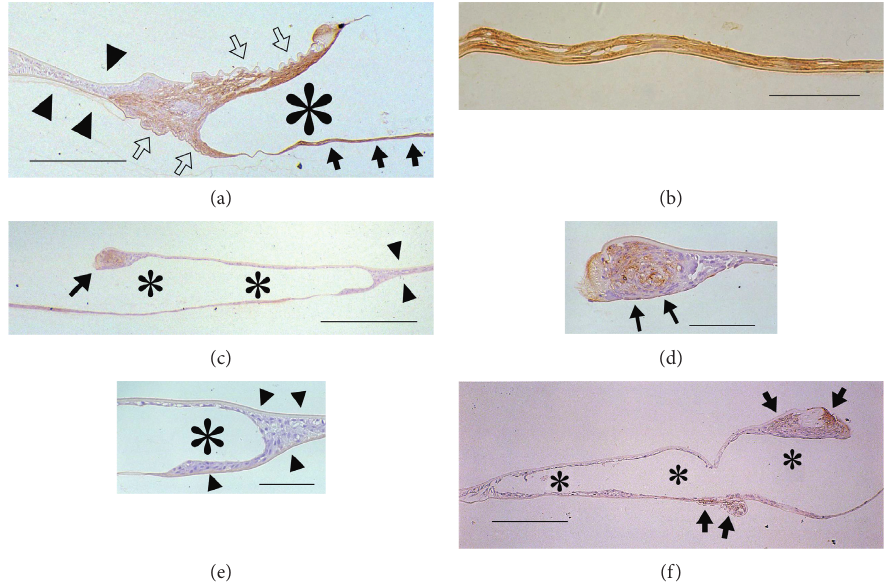
Figure 2: Immunolocalization of α -SMA in pseudophakic rabbit eyes 5 days after cataract surgery. The flattened and multilayered LECs are positive for α -SMA. The specimens could be divided into two groups according to the distribution of these α -SMA-positive LECs around the IOL optics. (a) Surrounding type: LECs positive for α -SMA surround the IOL optic. The anterior and posterior capsules around such LECs appear wrinkled (open arrows) except for the posterior capsule under the IOL optic (arrows). The inner surface of the peripheral anterior and posterior capsule is covered by a monolayer of LECs, with these two surfaces being attached to each other like a zipper (arrowheads), which are separated from the IOL optic by α -SMA-positive LECs around the IOL optic edge. These LECs are negative for α -SMA. Bar � 250 μ m. (b) Higher power view of (a): the central posterior capsule under the IOL optic is covered by α -SMA-positive LECs without wrinkling of the capsule. (c) Restricted type: LECs positive for α -SMA are present only around the margin of the anterior capsule (arrow). Other LECs around the IOL optics are negative for α -SMA, with most of them forming a monolayer. The inner surface of the peripheral anterior and posterior capsule is also covered by a monolayer of α -SMA-negative LECs (arrowheads). Bar � 400 μ m. (d) Higher power view of (c): the margin of the anterior capsule is covered with α -SMA-positive, flattened LECs (arrows). Bar � 75 μ m. (e); higher power view of (c): LECs around the edge of the IOL optic and on the inner surface of the peripheral anterior and posterior capsules are α -SMA-negative (arrowheads). Bar � 75 μ m. (f) Restricted type: LECs positive for α -SMA are present around the margin of the anterior capsule and on small areas of the posterior capsule (arrows). Bar � 200 μ m. (a–f) Sections were stained with 3-3’-diaminobenzidine hydrochloride and counterstained with hematoxylin. The asterisks indicate the IOL